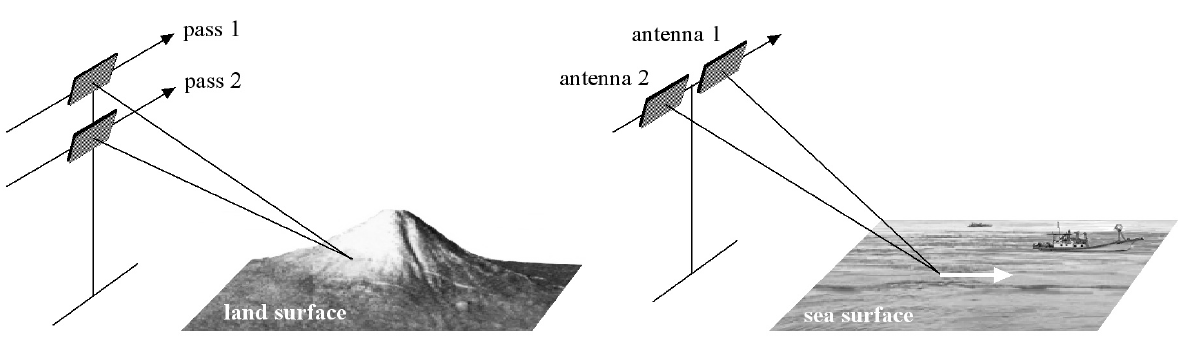
Figure 10. Geometry of repeat-pass CT (Cross-Track)-InSAR ( left ) and AT (Along-Track)-InSAR ( right ).